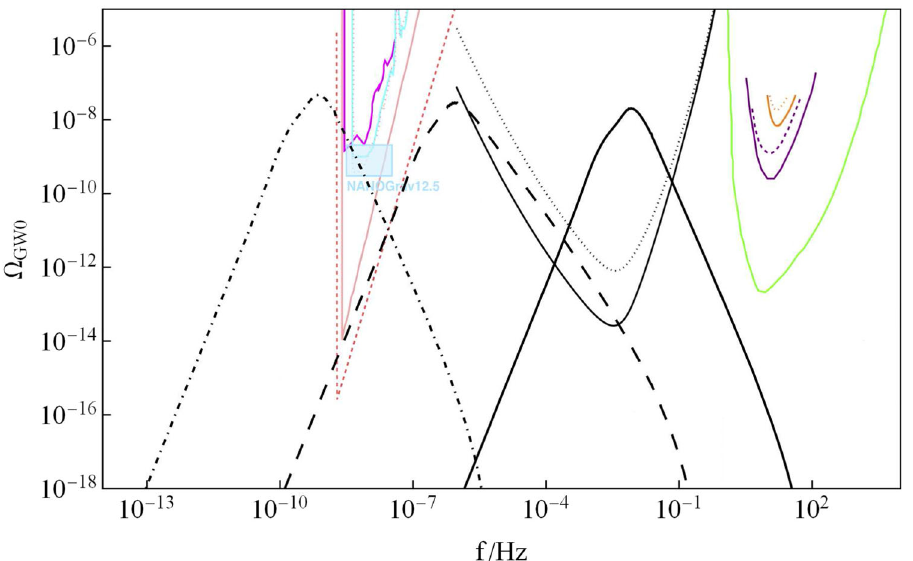
Fig. 9 The present fractional energy density of the secondary GWs in terms of frequency. The thick solid, thick dashed, and thick dash- dotted black plots correspond to Cases 1, 2, and 3, respectively. The sensitivity regions of the GWs ground-based interferometers including aLIGO O2 (dotted orange) and O3 (solid orange) runs [159,160,176], projections for the HLV (LIGO-Hanford, LIGOLivingston and Virgo) network at design sensitivity (dashed purple), the mid-scale upgrade of aLIGO (A+ detectors, solid purple) and the ET (light green) [166]